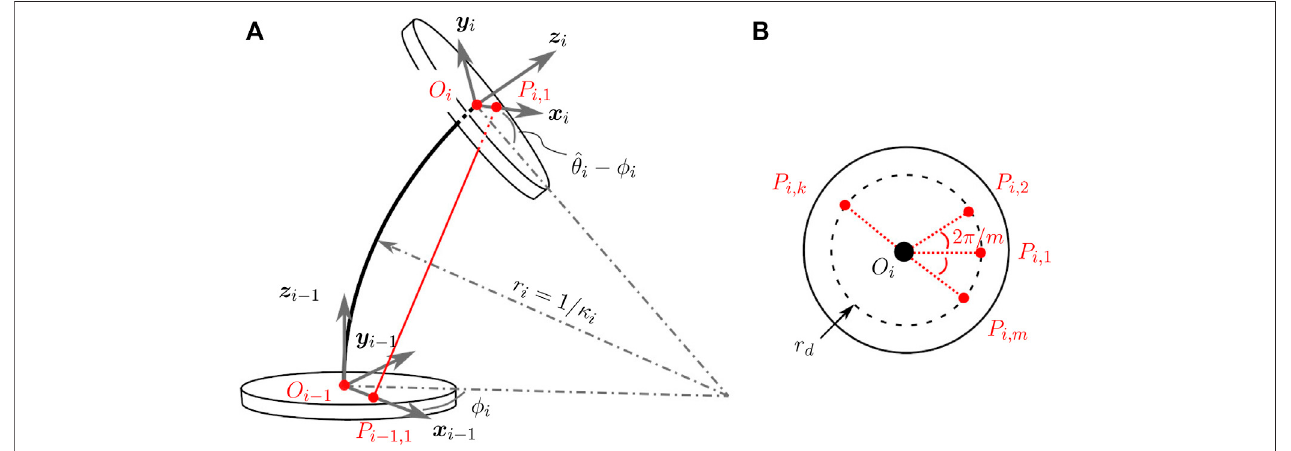
FIGURE 4 | (A) Diagrammatic representation of two disks i and i − 1 and the portion of the backbone between them. The corresponding frames attached at O i − 1 and O i have been indicated. Only one tendon has been marked red for clarity. (B) The m tendons are arranged concentrically around the backbone at a distance of r d